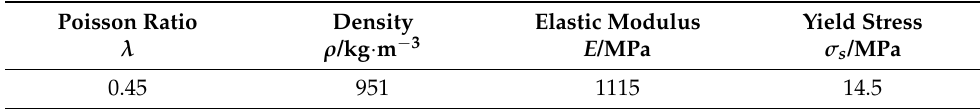
Figure 6. Stress-Strain curve of HDPE pipe. Table 1. Material parameters of HDPE pipe.